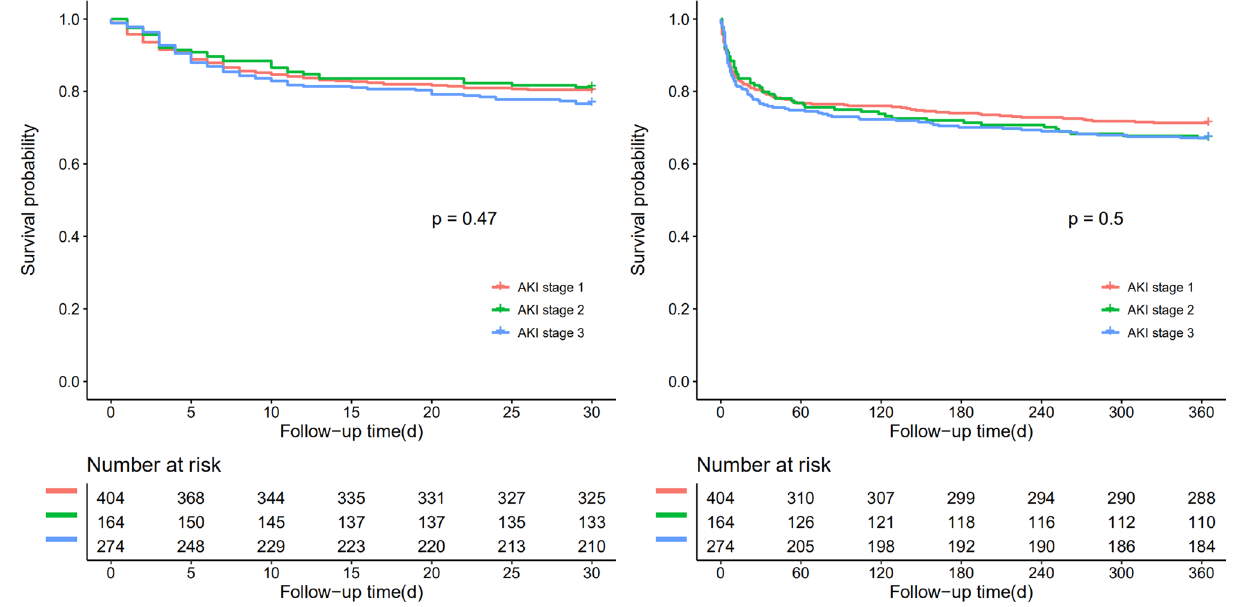
Figure 2. Patient survival within 30 days and 1 year of patients with different stages of AKI. Follow-up time (day): refers to the time since the AKI of diagnosis.